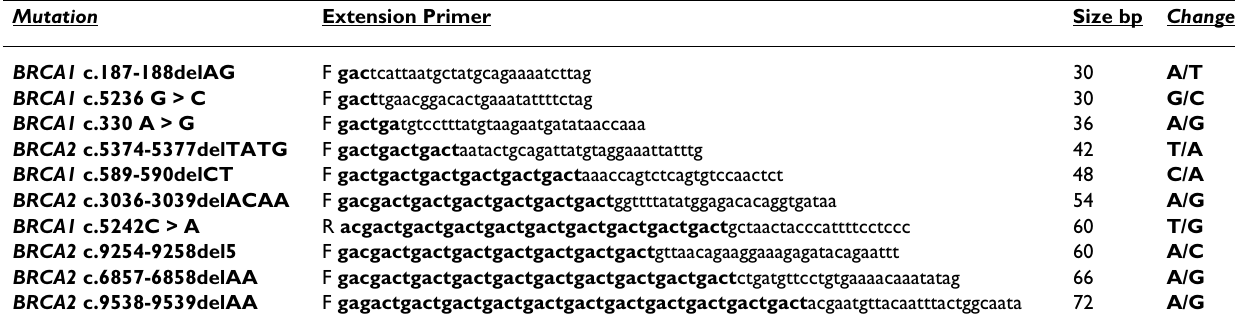
Table 2: Extension primer sequences Mutation